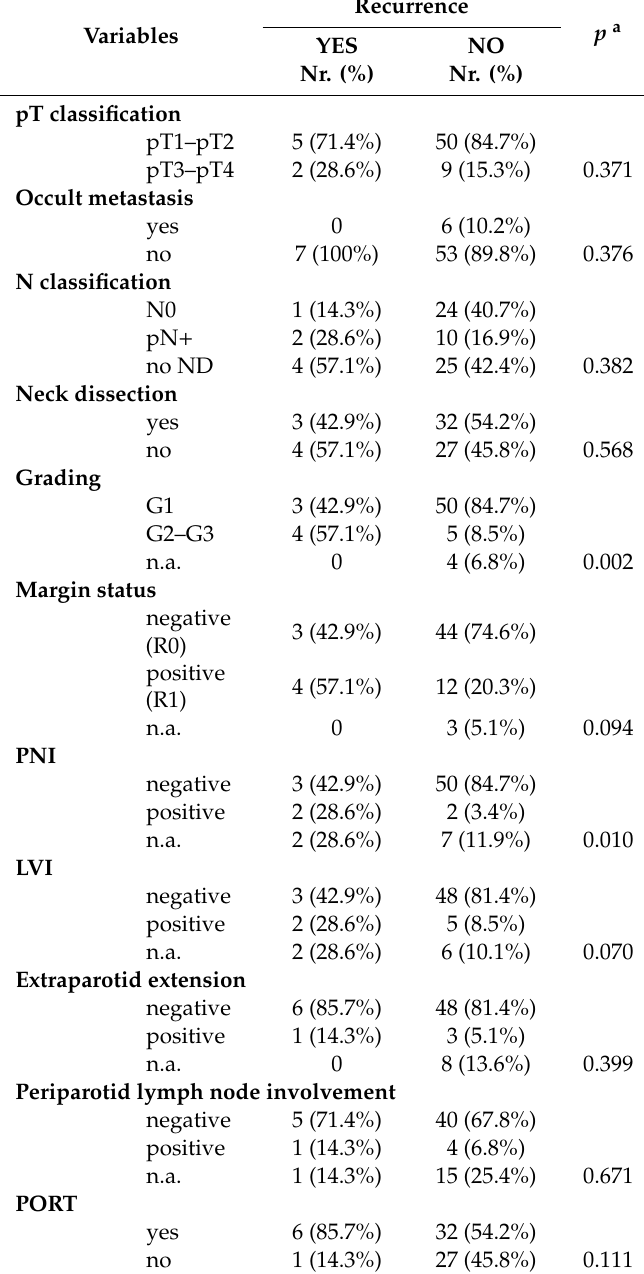
Table 3. Clinicopathological variables and